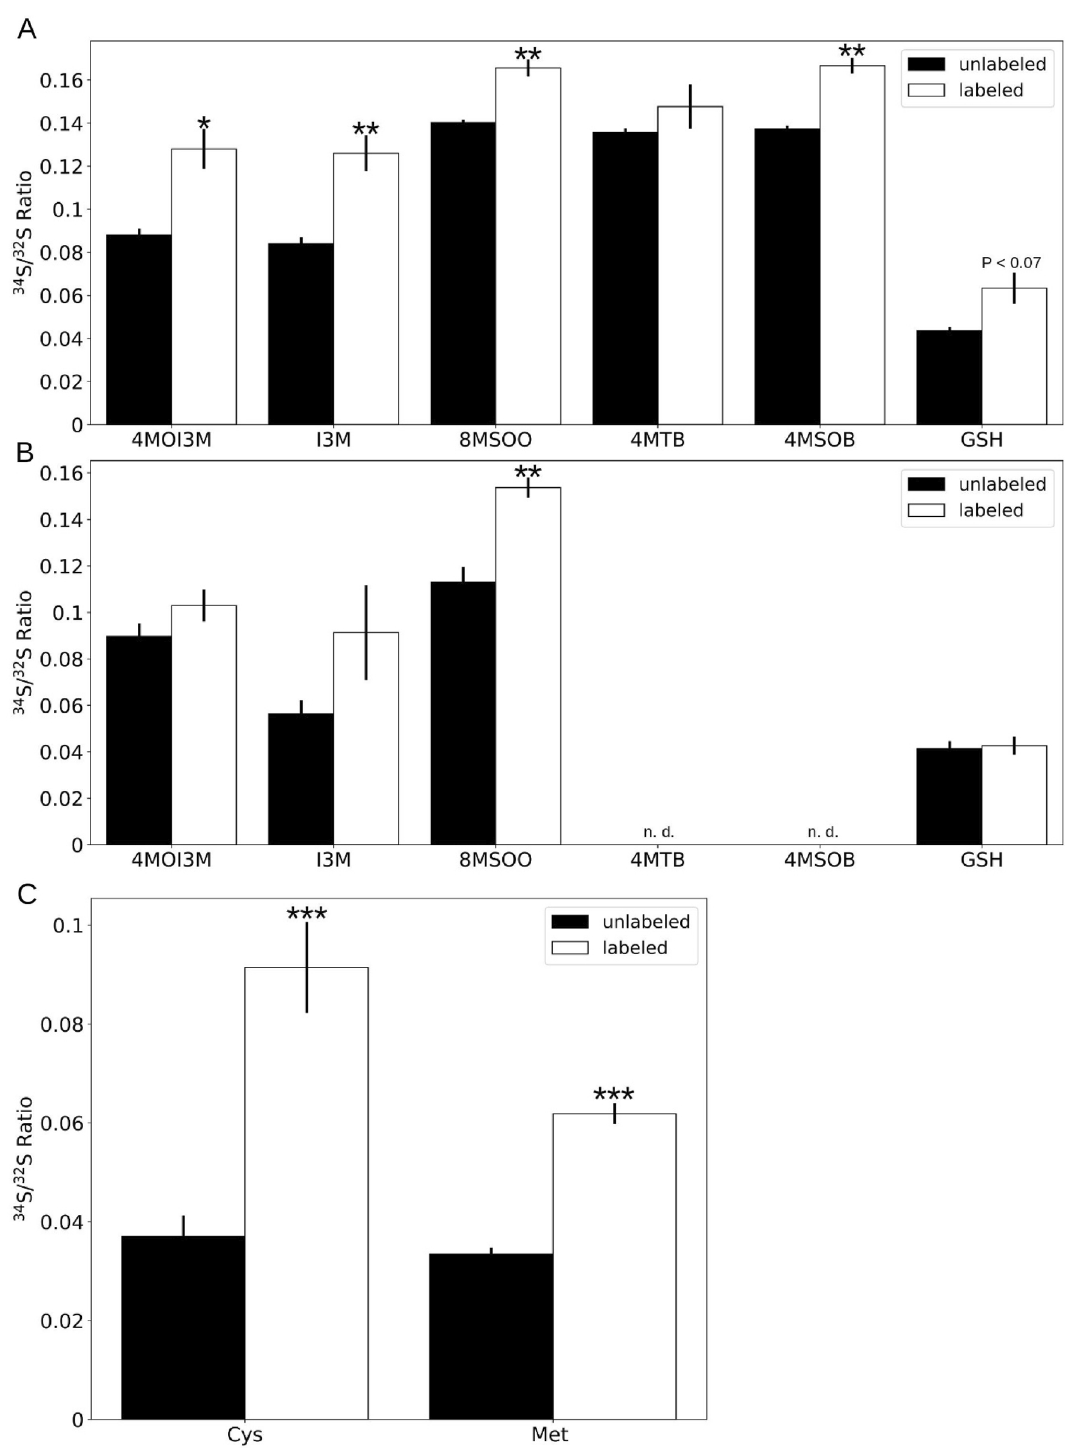
Figure 2. Sulfur atoms from fungal volatiles are incorporated into plant tissues. ( A,B ) 34 S/ 32 S ratios of glucosinolates and glutathione in shoot ( A ) and root ( B ) tissues. ( C ) 34 S/ 32 S ratio of cysteine (Cys) and methionine (Met) from Arabidopsis shoot. M. hyalina was grown on modified KM plates with the addition of 32 S-ammonium sulfate (unlabeled) or 34 S-ammonium sulfate (labeled), and co-cultivated with Arabidopsis seedlings in a desiccator. Error bars represent SEs from 3 biological replicates, each contains at least 3 technical replicates from 16 seedlings. Asterisks indicate significance level from Student’s t-test between unlabeled and labeled samples (*p < 0.05; **p < 0.01; ***p < 0.001). n.d. not